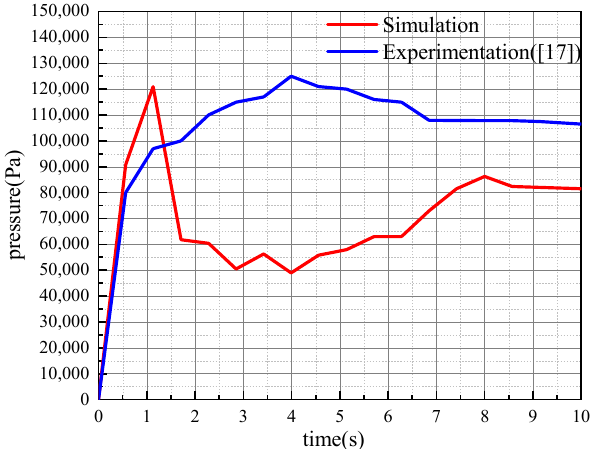
Figure 6. Graph of inlet pressure of pump at 50 mm particle size [17].